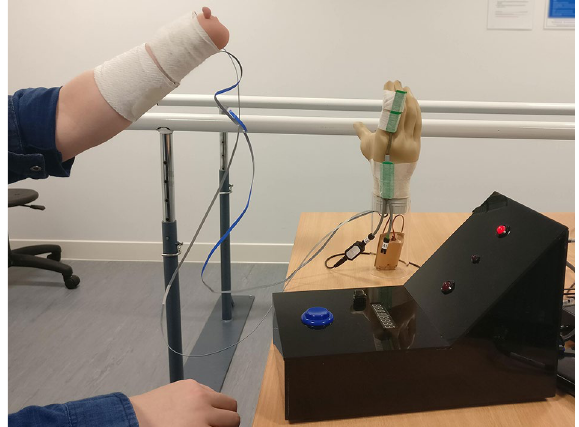
Figure 1. “Ideal” electrode skin interface. The electrode positions and gain settings were determined as described in Chadwell et al. 18 . These involve a mapping process starting at the muscle bulk and ending at the position where the signal is maximised, followed by adjustment of the electrode gain visualised using the Myoboy system developed by Ottobock Gmbh. To avoid movement of the electrodes, an elasticated bandage is used to hold them in place. The prosthetic hand is placed on the tabletop. Please note that this image shows a participant completing part of the unpredictability assessment. For the skill assessment, the forearm was held